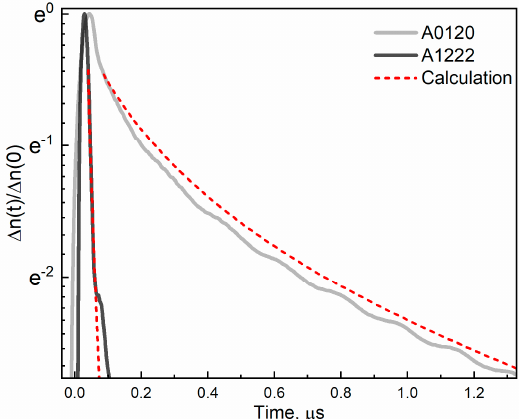
Figure 5. Carrier density kinetics (extracted from time resolved PC at 77 K) for str. #A0120 and #A1222 in comparison with the calculated relaxation kinetics. The initial non-equilibrium carrier density ∆ n(0) is 9 × 10 10 cm − 2 for both structures.